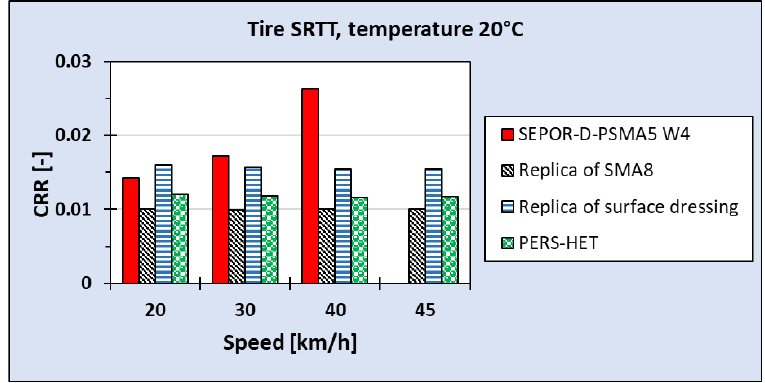
Figure 26. Coefficient of Rolling Resistance (CRR) as measured on the roadwheel facility at 20 °C.